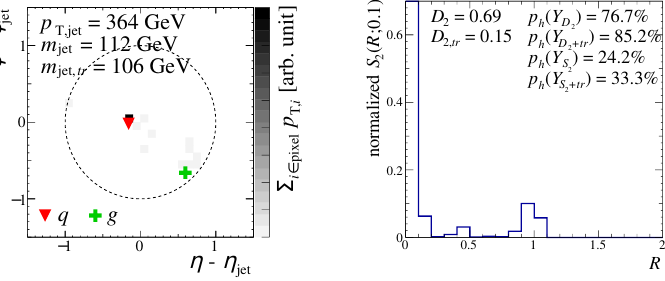
Figure 11 . The Pixelated jet image (left), and two-point spectrum S 2 ( R ; 0 : 1) (right) of a Higgs jet. The event is Higgs-like in the neural networks with D 2 , N D and N D , but it is not in those 2 2 + tr with S 2 ( R ), N S and N S . The sum of the bins of the spectrum is normalized to 1. The red 2 2 + tr triangles and green plus symbols in the pixelated jet images indicate direction of light quarks and gluons obtained from the matrix element including order (cid:11) S radiations. We show the Higgs-like probability p h ( Y X ) in an ANN model N X de(cid:12)ned by eq. (4.7).